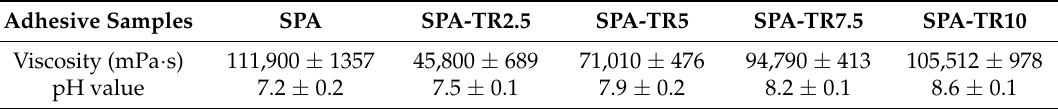
Table 2. The viscosity and pH value of different